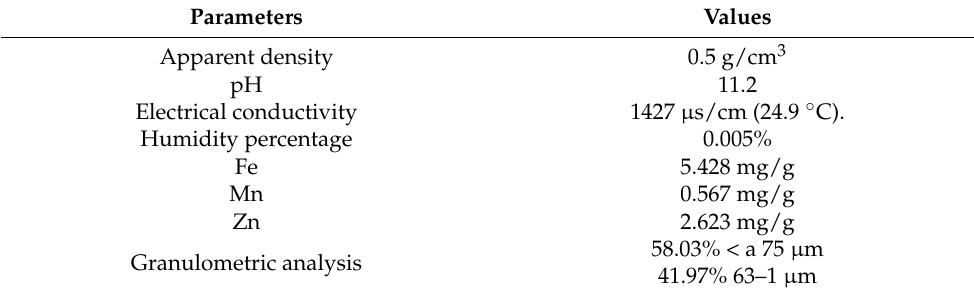
Table 1. Physicochemical parameters of sugar cane ash.